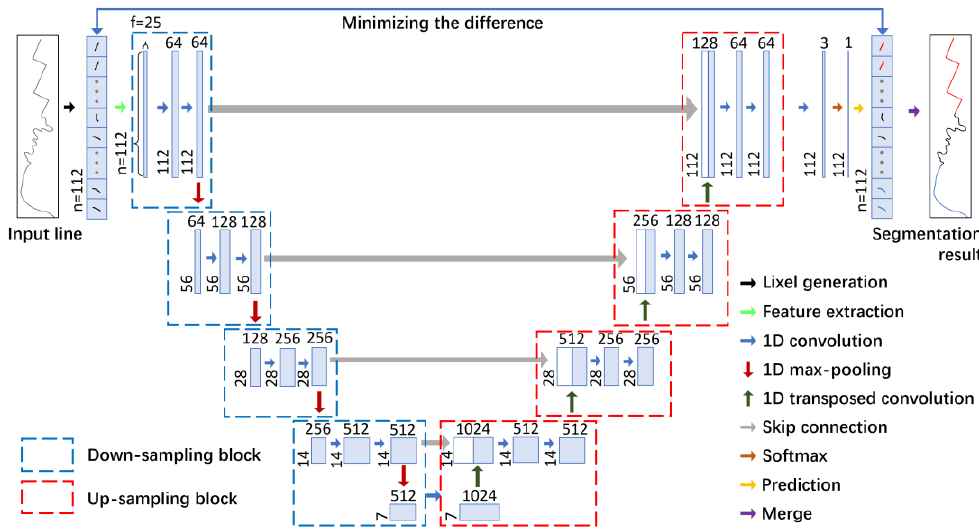
Figure 6. Architecture of the one-dimensional convolutional neural network (1D-U-Net) for classi- fying lixel pattern